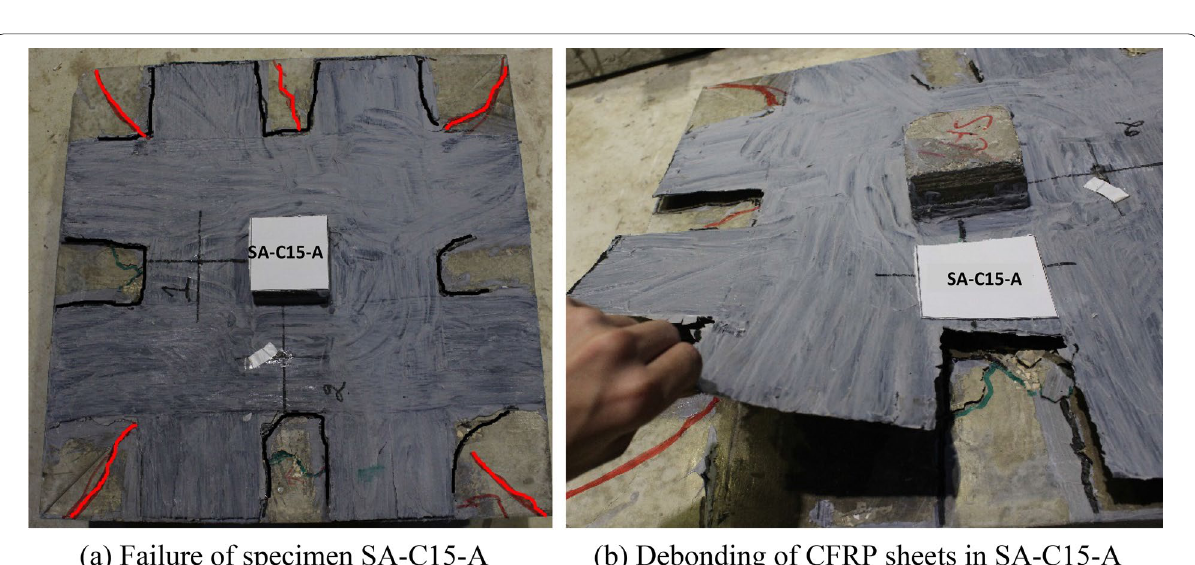
Fig. 7 Failure of specimens confined and strengthened by CFRP